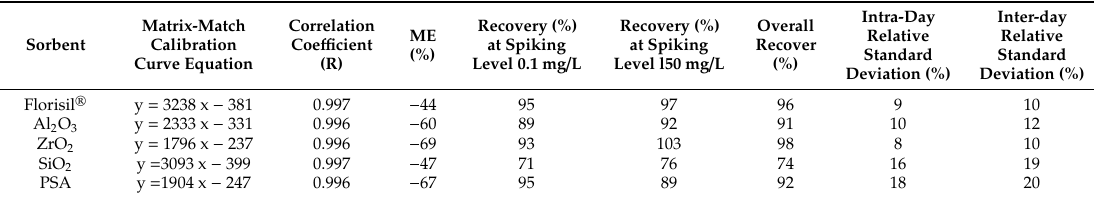
Table 2. Validation parameters for captan determination with the QuEChERS method with di ff erent sorbents in the dSPE method.